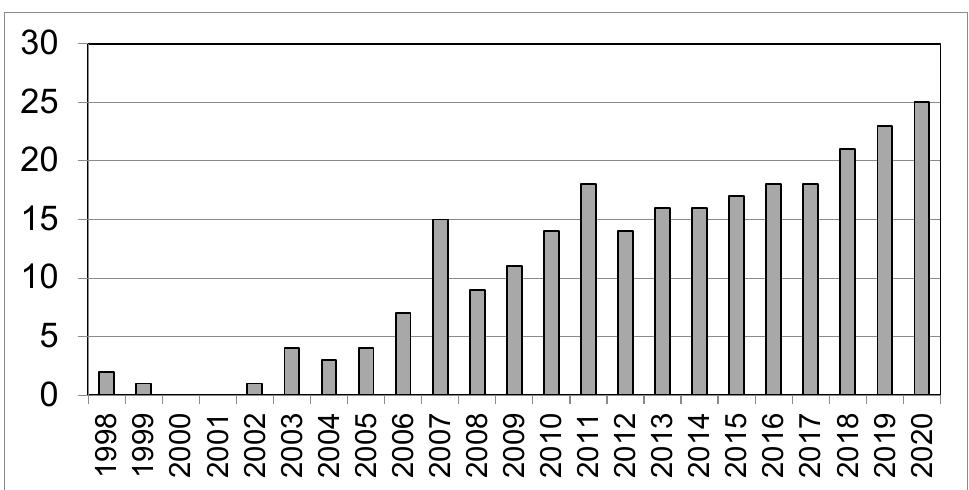
Figure 1. The number of papers related to Solid Phase Micro-Extraction (SPME) applications to